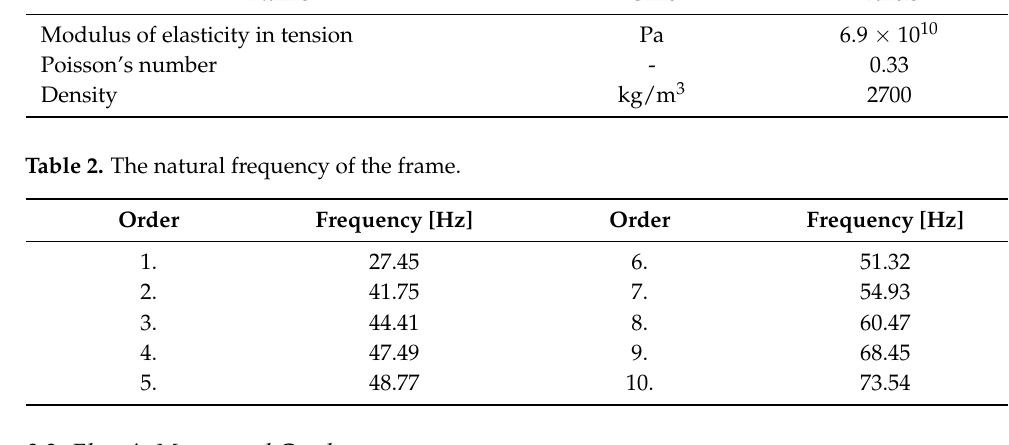
Table 1. The material properties of the aluminum alloy 6061.